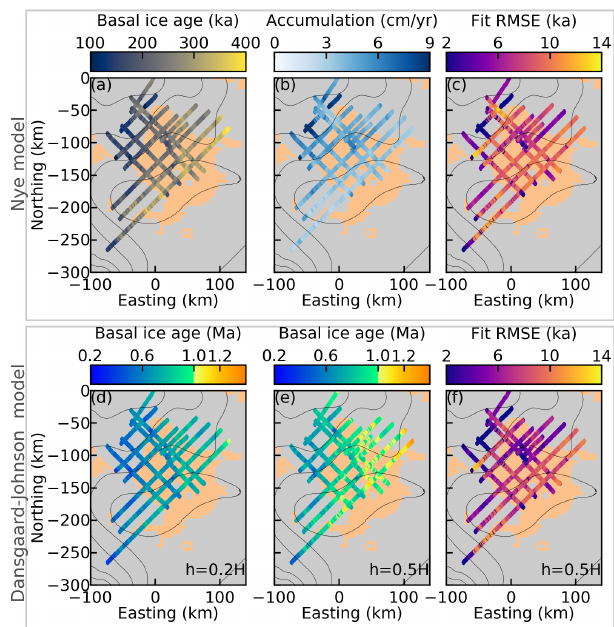
Figure 6. Age model results. The top shows the results of the Nye model and the bottom row the results of the Dansgaard–Johnson model. The RMSE fit is the difference between the model and the dated IRH. Accumulation is reported in ice equivalent units. In pan- els (d) , (e) , and (f) , “h” is the characteristic height used in the Dansgaard–Johnson model. Each panel is plotted over the candi- date A ice core target region in orange (Van Liefferinge and Pattyn, 2013) and 100m surface elevation contours (Bamber et al., 2009). The dome is surrounded by the 3100m contour. The coordinate sys- tem used is polar stereographic